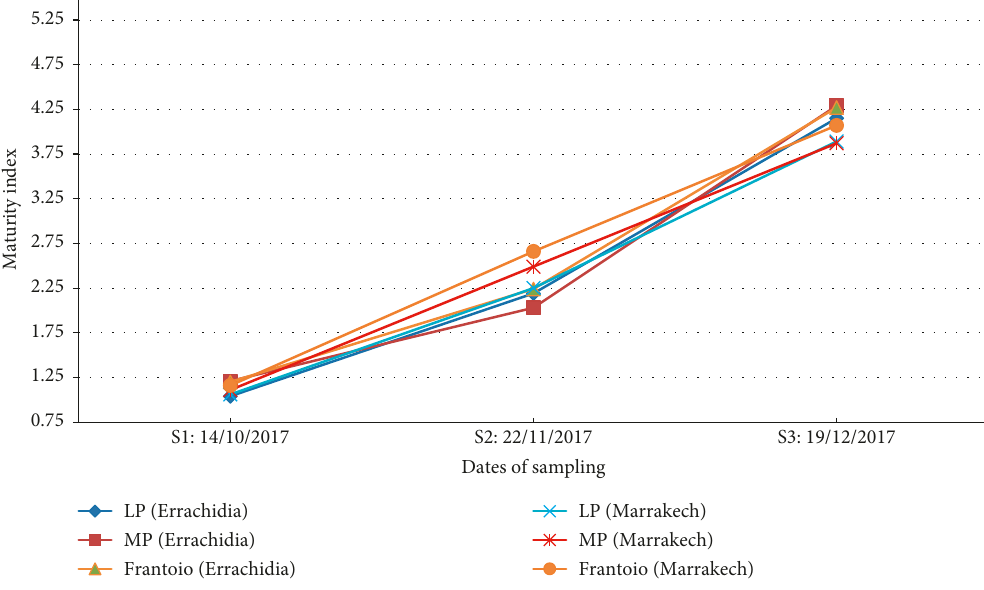
Figure 2: Olive maturity index evolution of the different cultivars grown in Marrakech and Errachidia regions during the 2017 season (LP: Languedoc Picholine; MP: Moroccan Picholine; Fr: